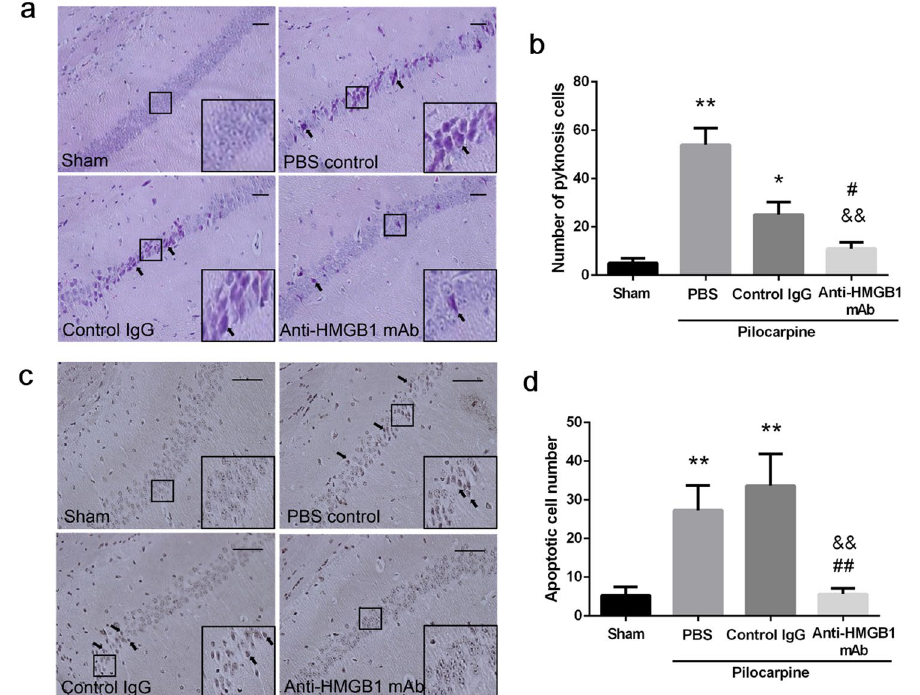
Figure 4. Histological analysis of neuron degeneration and apoptosis in the CA1 hippocampal region in acute status epilepticus mice. The brains were fixed with formalin at 4 h after anti-HMGB1, control IgG or PBS administration, and paraffin-embedded sections were stained with hematoxylin-eosin. Arrows indicate typical pyknotic cells. Scale bars equal 50 μ m. * p < 0.05, ** p < 0.01 compared with the sham. && P < 0.01 compared with the PBS control. # p < 0.05 compared with the control IgG group ( a ). The number of pyknotic cells was counted in each mouse and the results are shown as the means ± SEM of 8 mice ( b ). Apoptotic cells were detected by TUNEL staining. The arrows indicate the apoptotic cells ( c ). The number of apoptotic cells in the CA1 region was counted in each mouse and the results are shown as the means ± SEM of 8 mice. ** p < 0.01 compared with the sham control. && p < 0.01 compared with the PBS control. ## p < 0.01 compared with the control IgG group ( d